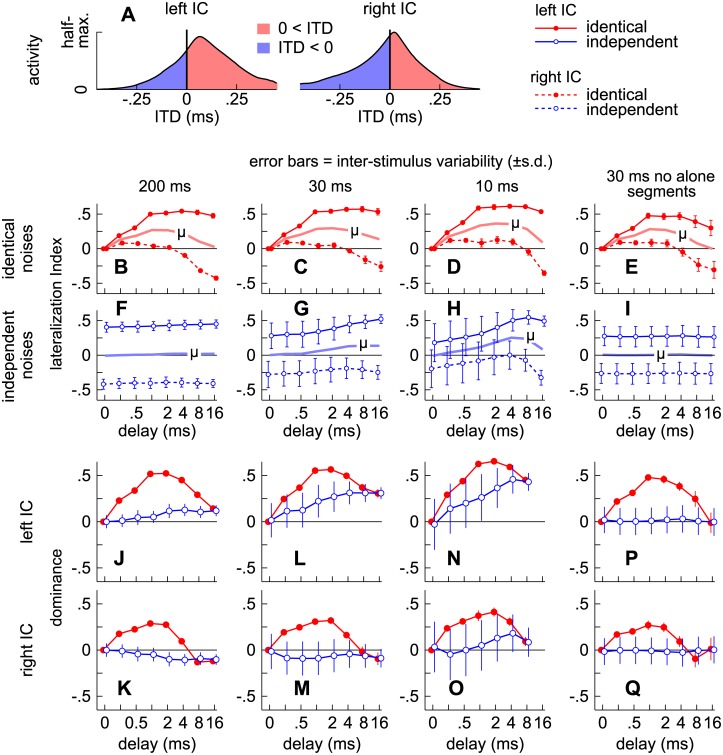
Empirical predictions of localization dominance.(A) Modeled half-maximal activities, averaged across frequency, in the left and right ICs when the lead-lad delay was 4 ms and the noise-pairs were identical. (B-I) Lateralization indices (LI) indicating the degree to which half-maximal activities in the left and right ICs correspond to leading or lagging (positive or negative) ITDs after averaging across frequency. (J-Q) Empirical predictions of localization dominance obtained as a product factors described by Eq 7.